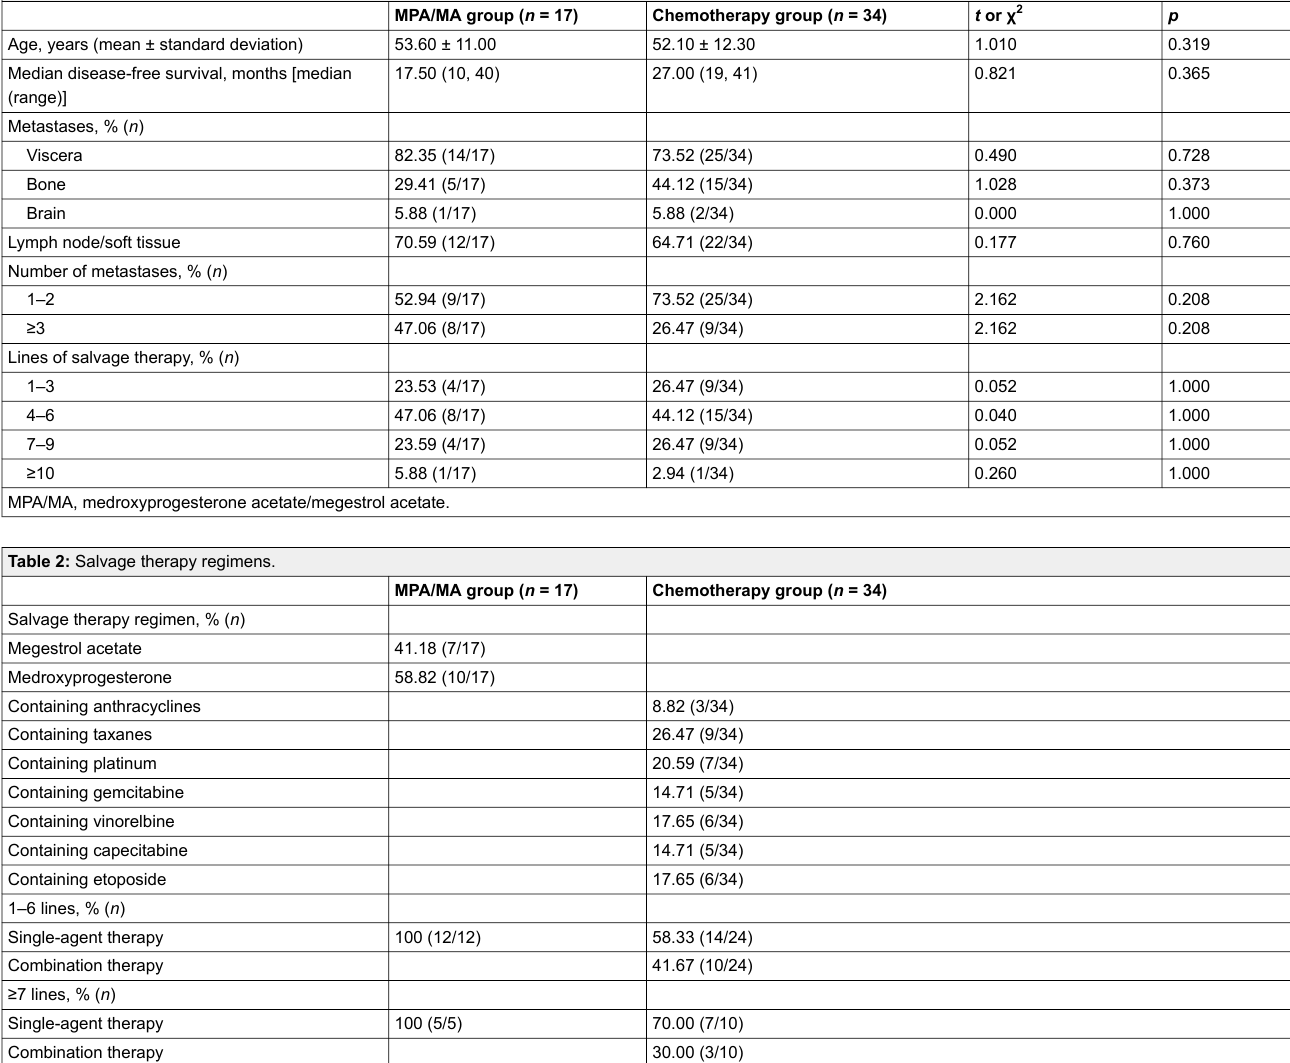
Table 1: Patient characteristics.